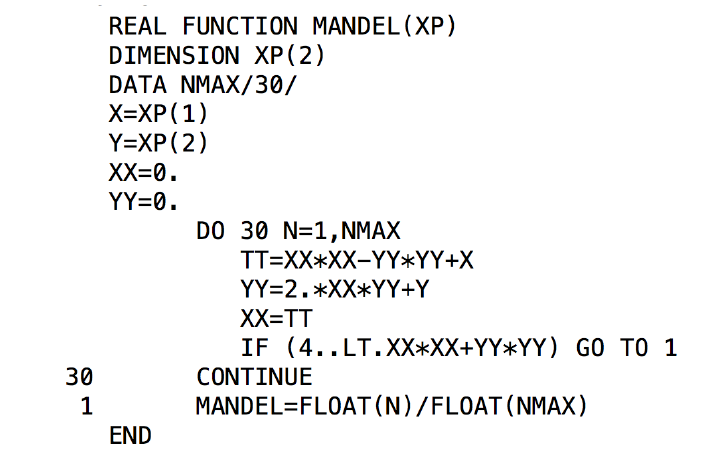
Figure 2. pawex1.kumac with gopaw Figure 4. PAW mandel.f COMIS script